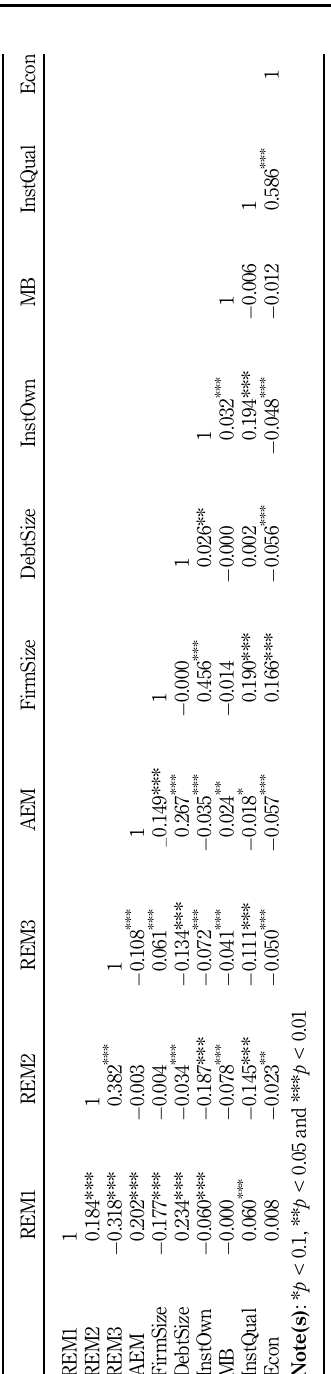
Table 3. Pearson